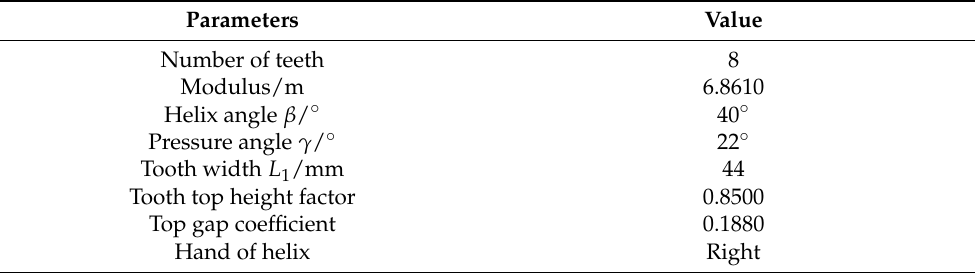
( b ) Figure 3. Two induction coil structures: ( a ) transverse coil, ( b ) longitudinal coil. Table 2. Induction heating coil parameters. Parameters